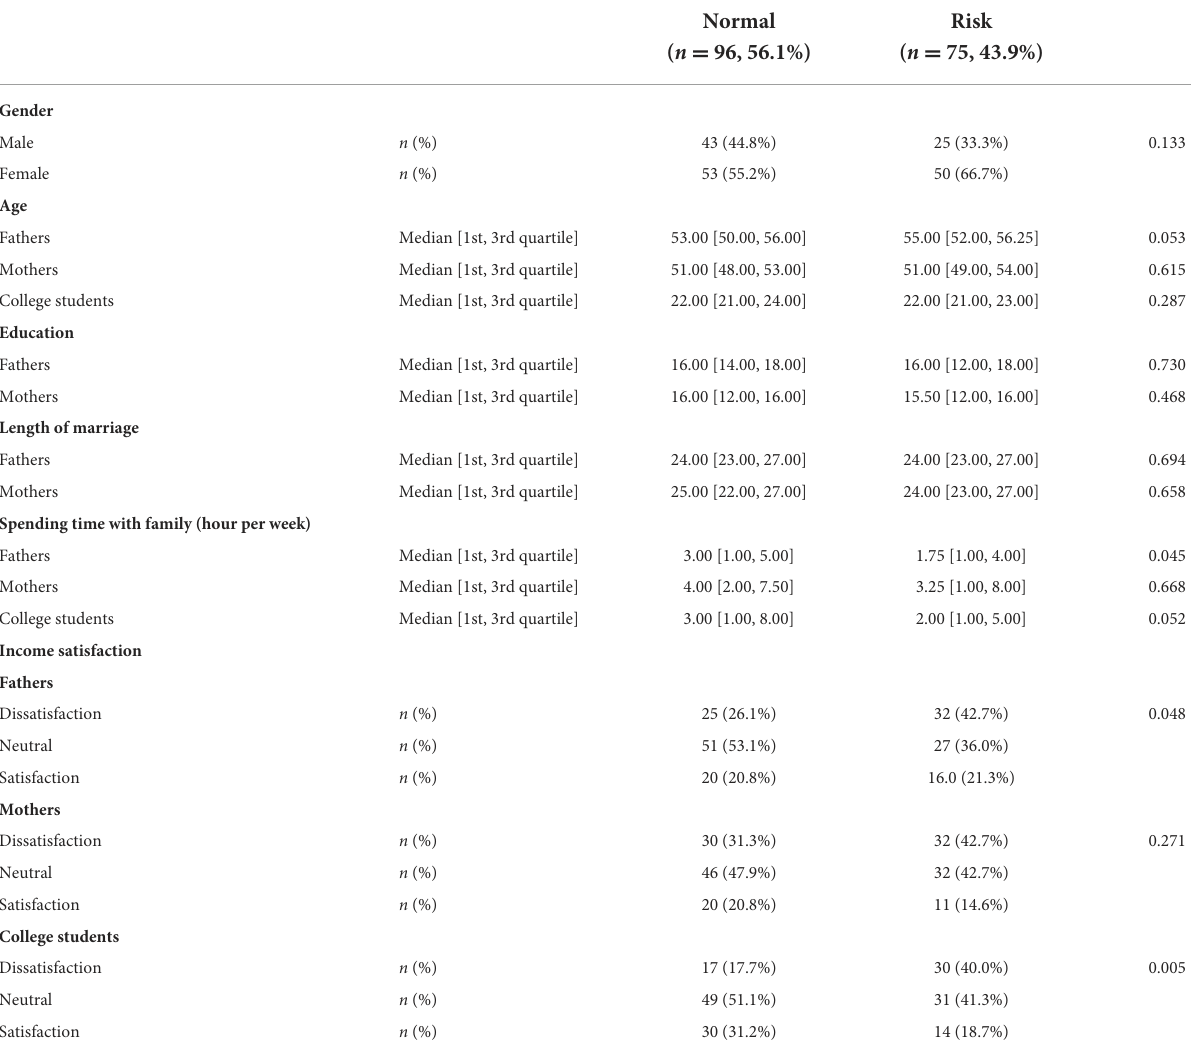
TABLE 2 Demographic characteristics of college